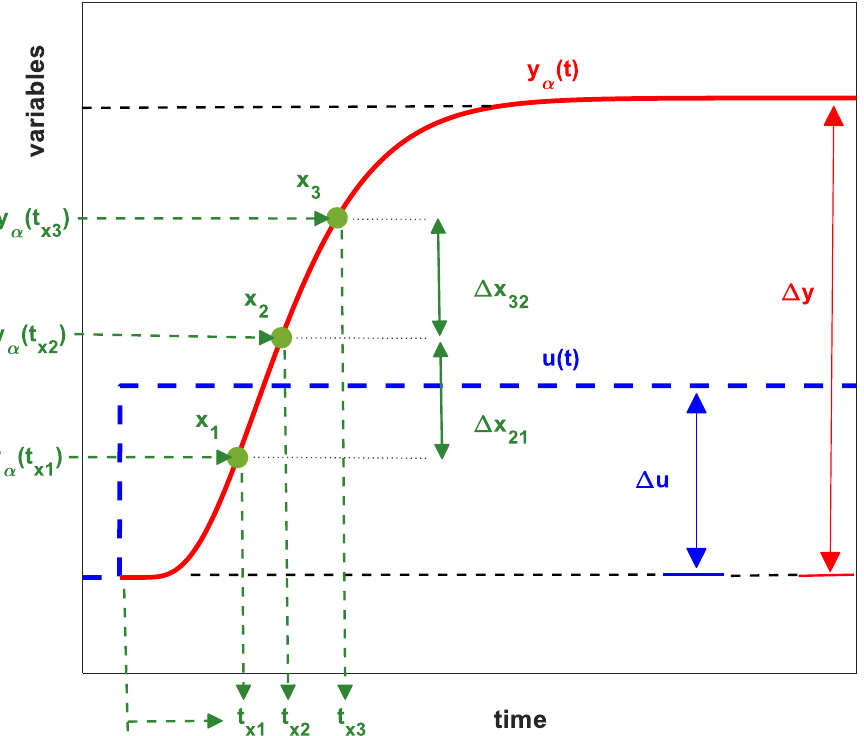
Figure 3. Process reaction curve y α (t), arbitrary representative points {x 1 , x 2 , and x 3 } on the process reaction curve, and step-input signal u(t). Data obtained from the process reaction curve required for the identification procedure are { ∆ y, ∆ u, t x1 , t x2 , t x3 }. Note that ∆ x 21 and ∆ x 32 represent a variation of (x 2 − x 1 )% and (x 3 − x 2 )% from the centroid x 2 to the extreme points x 1 and x 3 ,